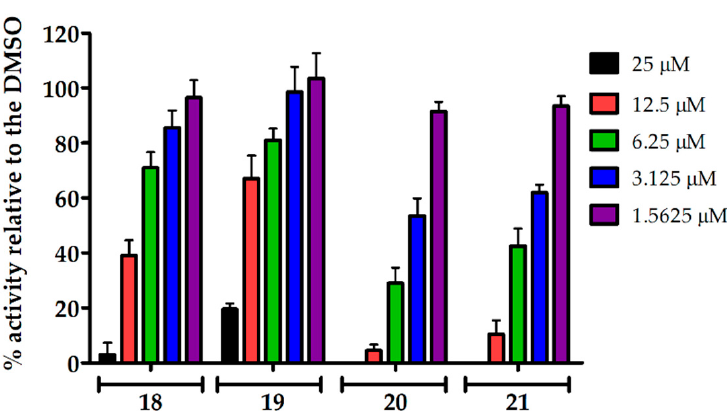
Figure 4. The effect of uridine glycoconjugates on TBEV infection in A549 cells. A549 cells were infected with the TBEV Neudoerfl strain at an MOI of 0.001. At 2 h p.i. the virus was removed, cells were washed and overlaid with carboxymethylcellulose in Dulbecco’s Modified Eagle’s Medium with DMSO or various doses of tested compounds (0–25 μ M). At 48 h p.i., cells were fixed, and infected foci were visualized by immunostaining with the monoclonal anti-Flavivirus group antigen antibody (4G2). Viral plaques were counted and expressed as percentage in comparison to the number of plaques detected in DMSO-treated infected cells set as 100%. Error bars represent standard deviations from 3 separate experiments. Table 1. Antiviral activity of uridine glycoconjugates 18–21 against TBEV Neudoerfl strain. Type of Uridine Glycoconjugate Structure